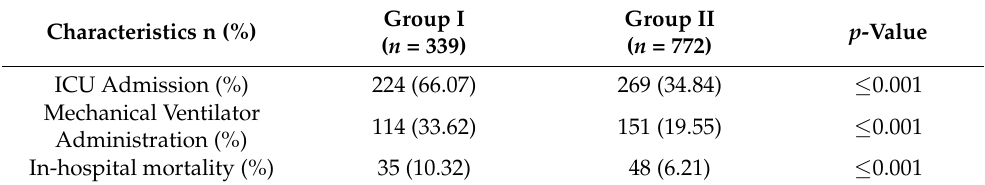
Figure 7. Hospitalization (days) in patients with normocreatinemia (Group-I) and hypercreatinemia (Group-2).